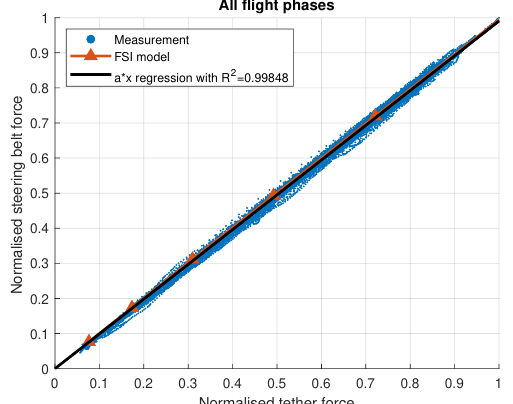
Figure 9. Normalized tether force as a function of normalized steering belt force obtained during a total of 154 power cycles including all flight phases, but only data when no steering input was applied are shown. The measurements were smoothed with a 3 s moving average